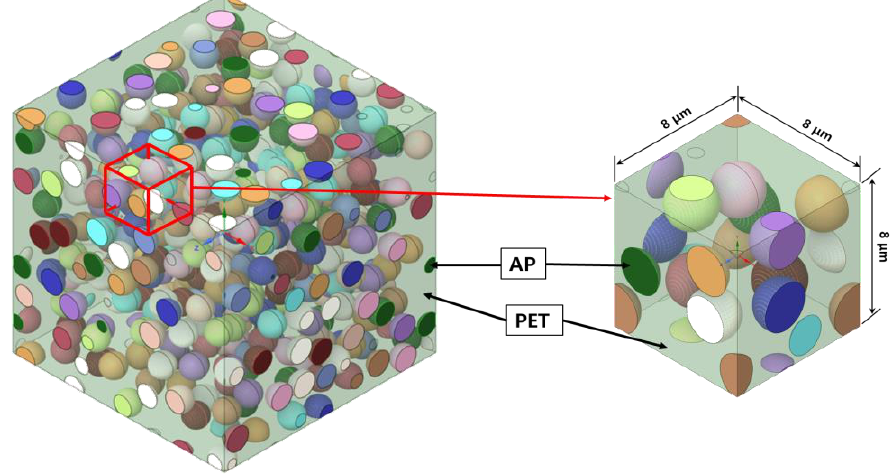
Figure 2. Selection method of representative volume element (RVE) modeling.